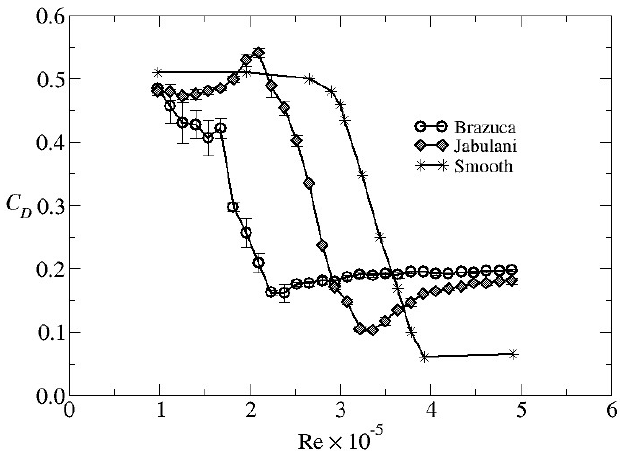
Figure 2. Drag coefficient as a function of Reynolds number and error bars for Brazuca and Jabulani soccer balls [1] and for a smooth ball